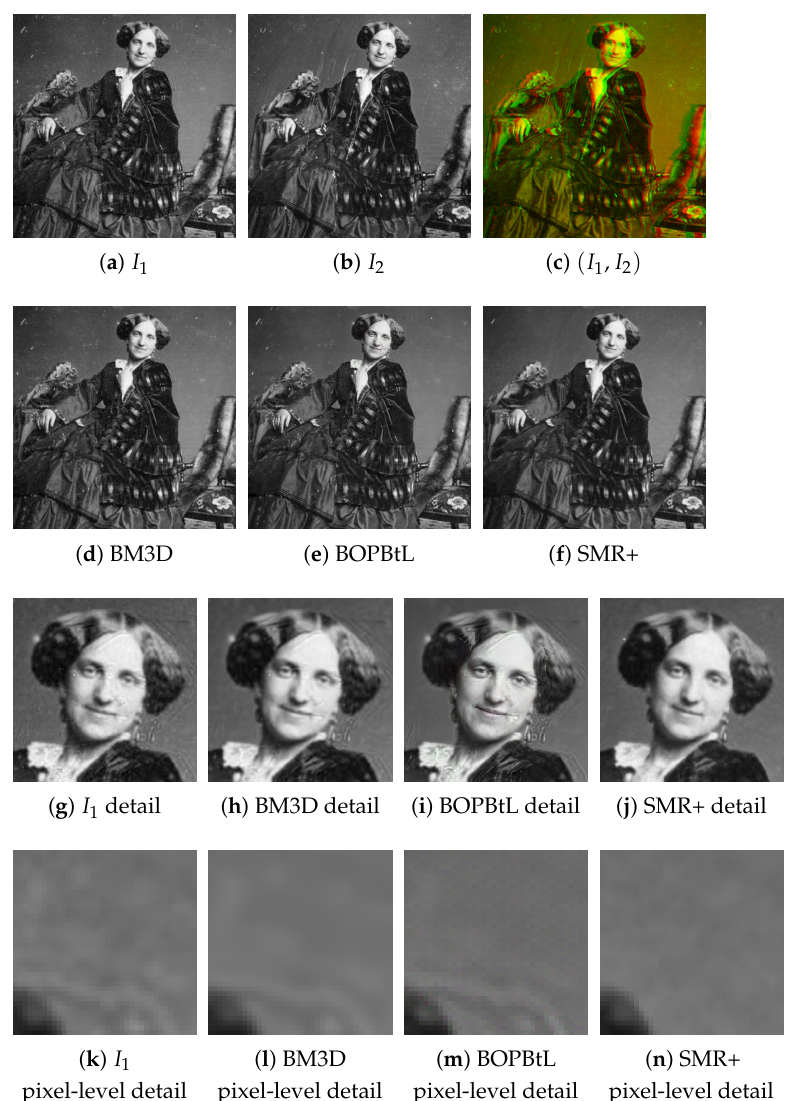
Figure 1. First row: An example of historical stereo pair of images, I 1 and I 2 , also superimposed as anaglyph. Second row: Enhancement of I 1 according to different methods, including the proposed SMR+ method. Although visually impressive, the deep super-resolution result of BOPBtL does not preserve the true input image. Third row: A detail of I 1 and the restored images according to the different methods. A closer look at BOPBtL reveals alterations with respect to the original face expression, accentuating the smile and introducing bush-like textures on the hair. Fourth row: pixel level detail of I 1 and of the restored images according to the different methods. The specific image region considered is the background around the right shoulder. Notice the chessboard-like texture pattern typical of the deep network approaches, not visible at coarser scales. Best viewed in color: the reader is invited to zoom in on the electronic version of the manuscript in order to better appreciate the visual